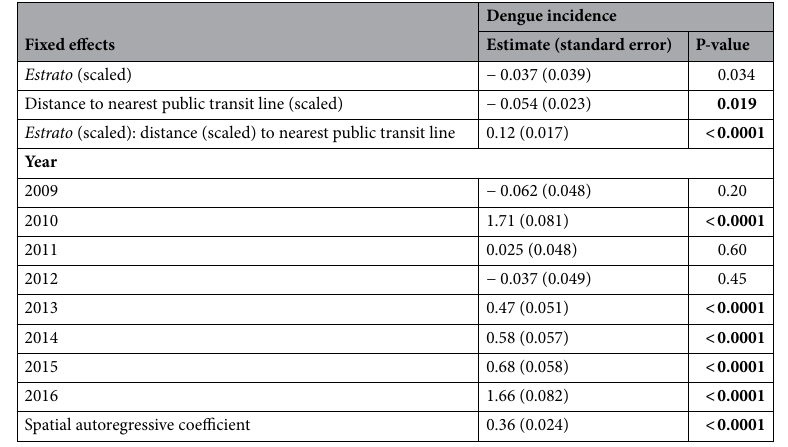
Table 1. Summary of spatial autoregressive models showing correlation between dengue incidence (dengue counts per population) and distance to nearest transit line, socioeconomic status as measured by Estrato , year, and the interaction between Estrato and distance to the nearest public transit line in Medellin, Colombia, 2008–2016. Estimates and standard errors are shown. Significant p-values are bolded. Estrato and distance to the nearest public transit line have been scaled to enable comparison of effect size. Dengue incidence has been log transformed.